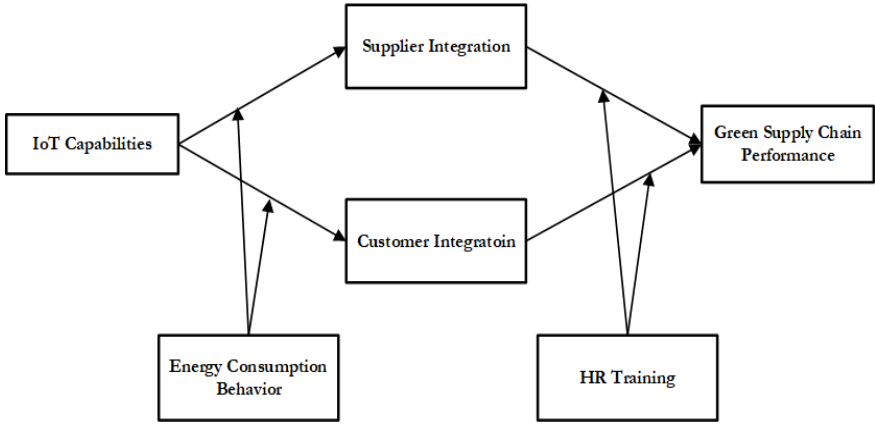
Figure 1. Proposed research model.